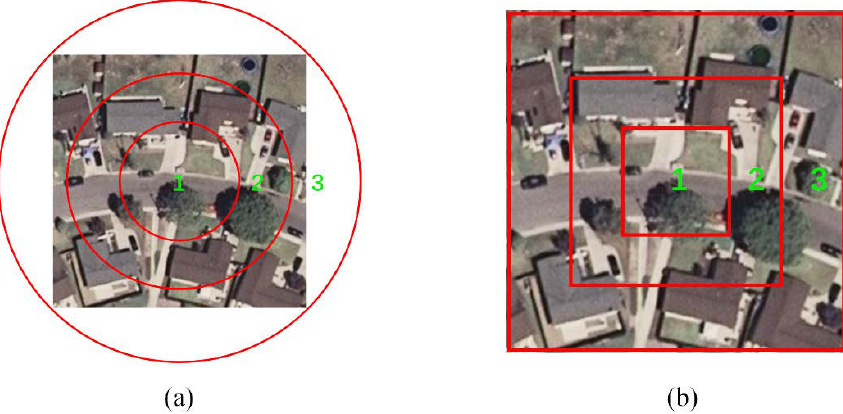
Figure 3. The example of the spatial partition of the concentric circle pooling strategy to represent spatial information. ( a ) The original concentric circle structure-based pooling method; ( b ) The proposed concentric circle pooling method.